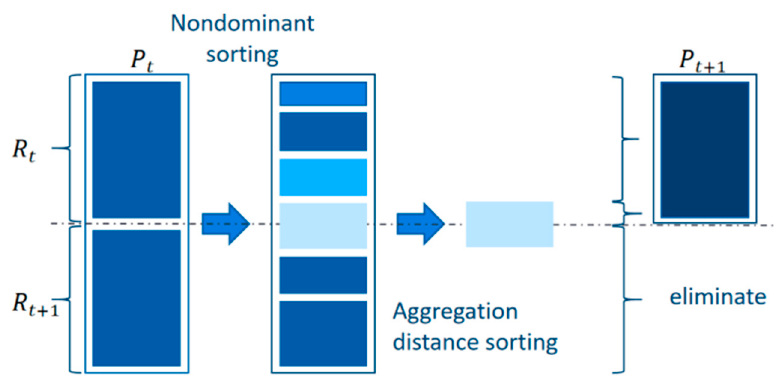
Figure 2. Example of a new species composition of the NSGA-II.